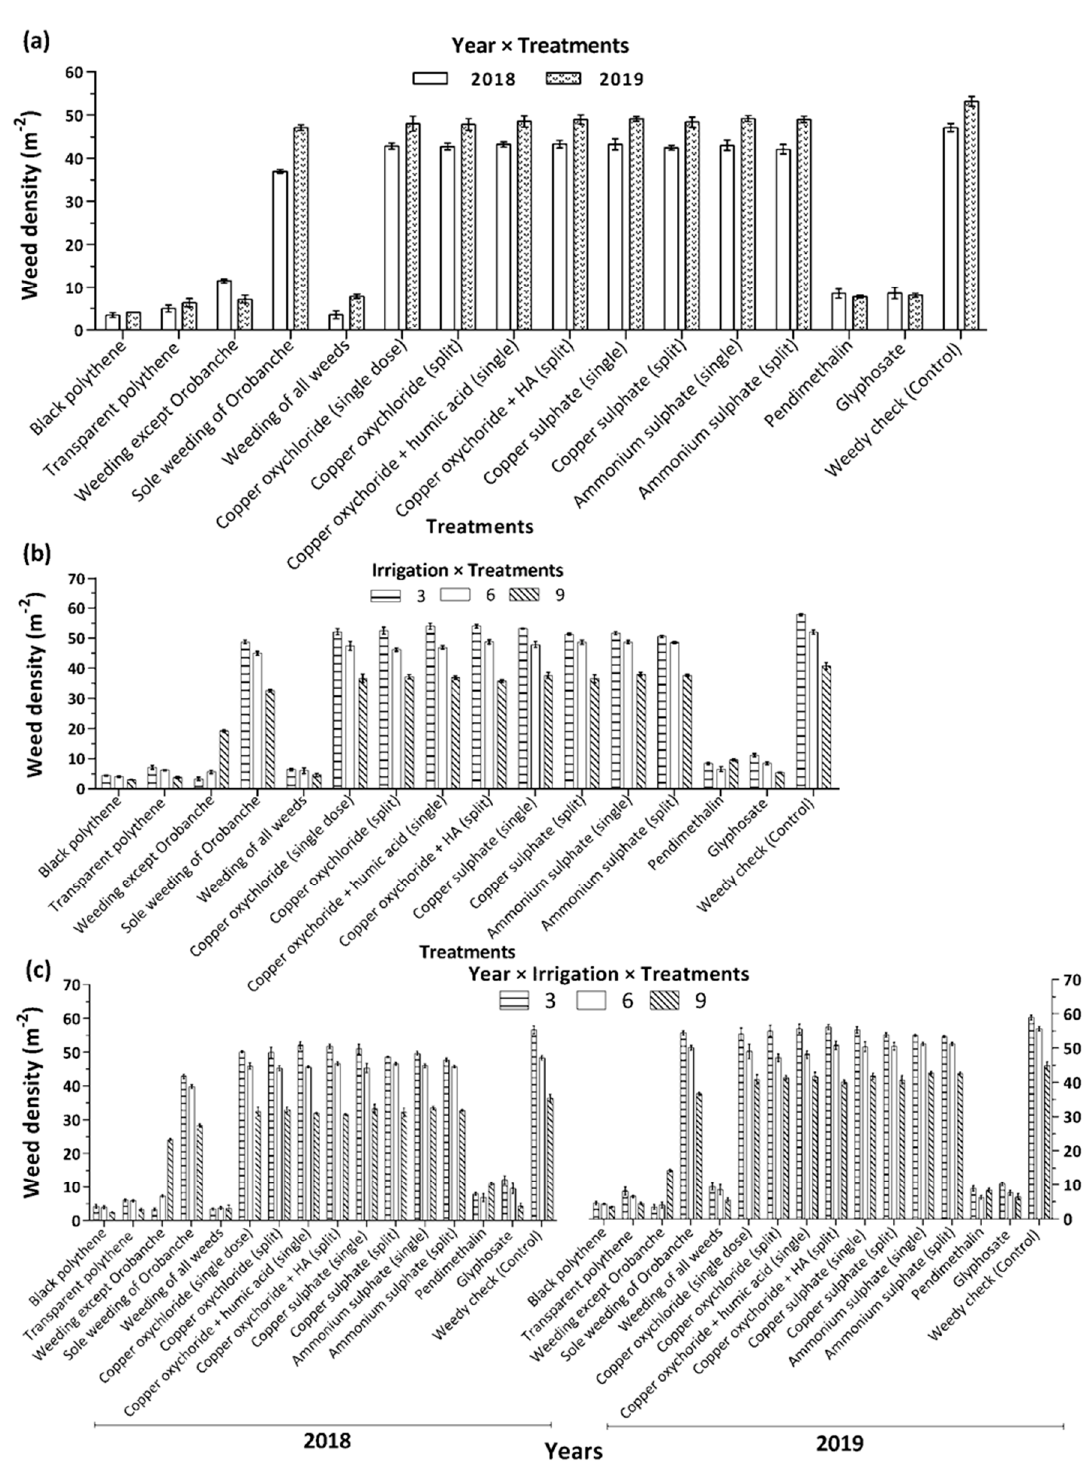
Figure 4. Influence of various interactions on weed density (m − 2 ). ( a ) Interaction effect of year × treatments on weed density. ( b ) Interaction effect of irrigation × treatments on weed density. ( c ) Interaction effect of year × irrigation × treatments on weed density.